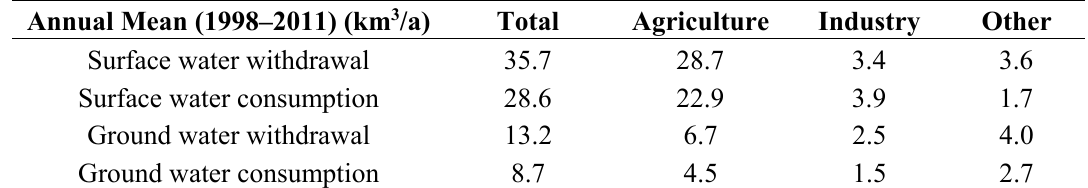
Table 5. Water withdrawal and consumption in the Yellow River Basin from 1998 to